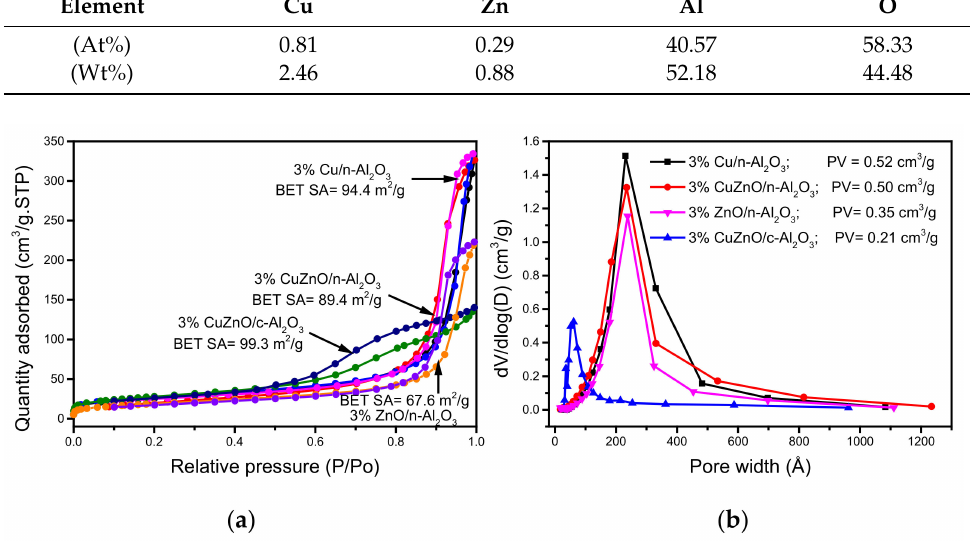
Figure 4. ( a ) Nitrogen adsorption–desorption isotherms and ( b ) pore size distribution curves of sample